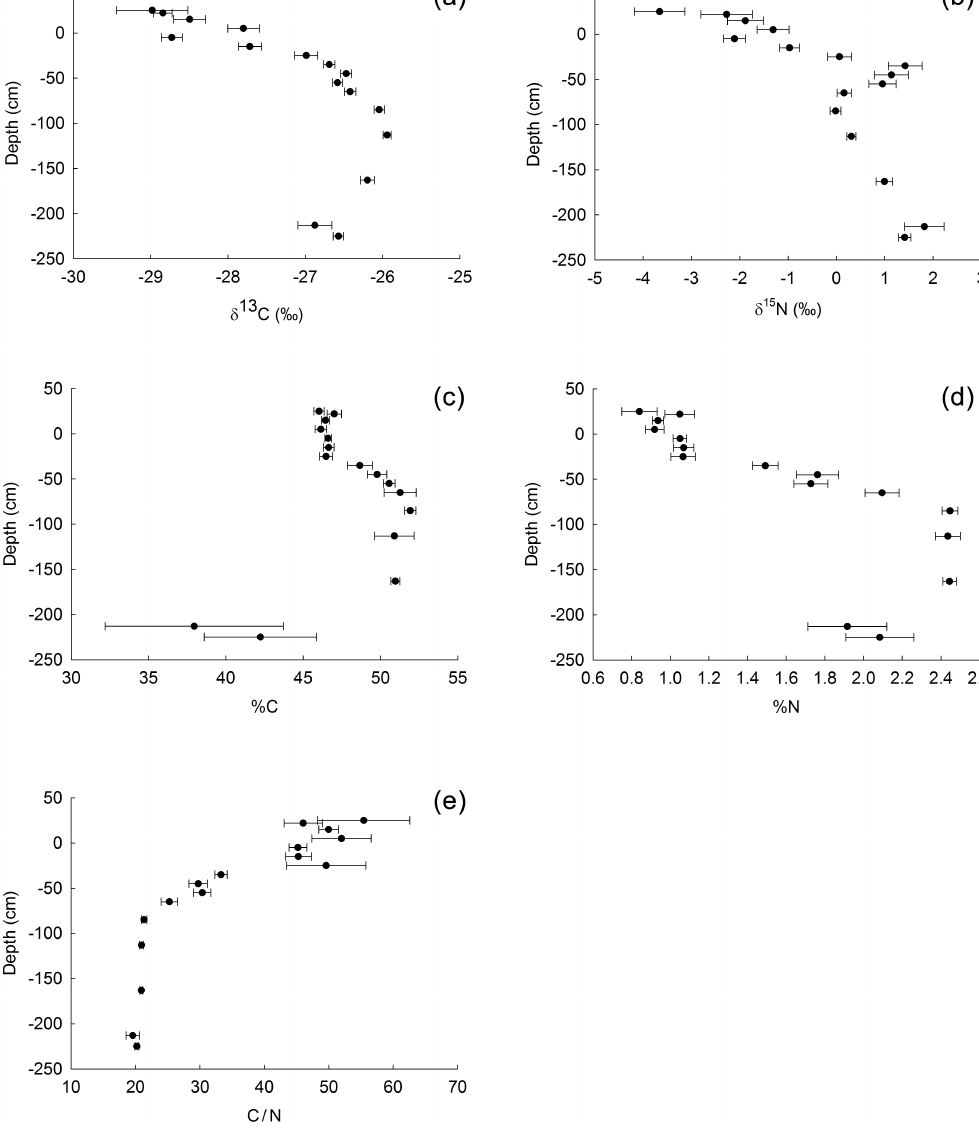
Figure 3. δ 15 N, δ 13 C, %N, %C, and C / N versus depth. Values ( ± SE) are averaged across hummock versus hollow cores and across treed versus non-treed cores. Averages ( ± SE) are given for each depth, with n given in parentheses following the depth: 25 (3), 22 (7), 15 (14), 5 (14), − 5 (19), − 15 (17), − 25 (17), − 35 (15), − 45 (17), − 55 (17), − 65 (17), − 85 (18), − 112 (17), − 162 (17), − 213 (3), and − 225cm (8). (a) δ 13 C versus depth, (b) δ 15 N versus depth, (c) %C versus depth, (d) %N versus depth, and (e) C /